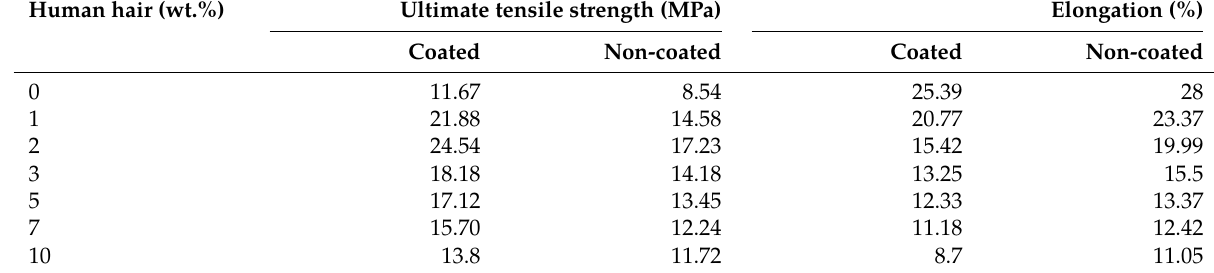
Table 2: Tensile properties coated and non-coated SPI resin reinforced with human hair. Human hair (wt.%)